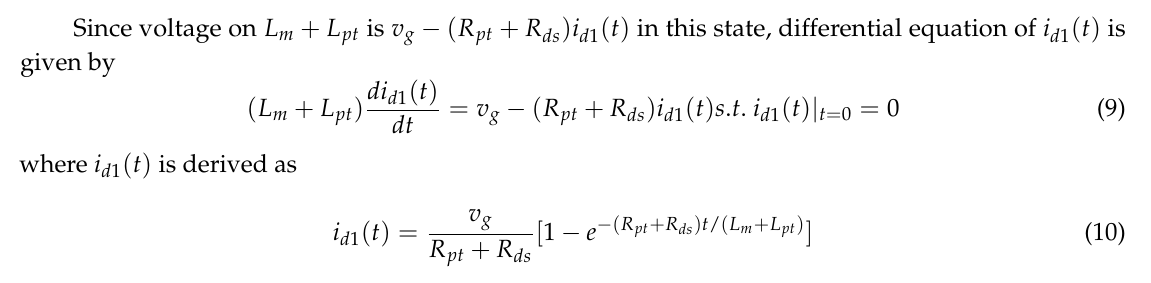
Figure 7. Flyback converter in switch-on state. ( a ) Active circuit, ( b ) Equivalent circuit scheme.